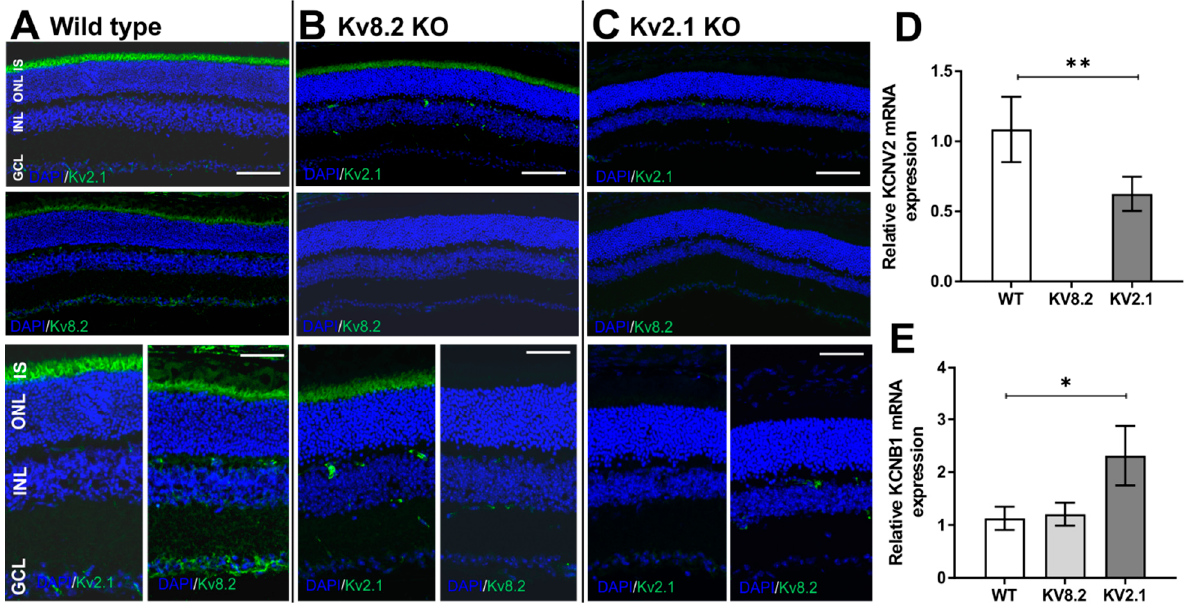
Figure 1. Retinal localization and expression of the voltage-gated K + channel protein subunits Kv8.2 and Kv2.1 in wild type (WT), Kv8.2 knockout (KO) and Kv2.1 KO. ( A – C ) Representative confocal images of the inner segment (IS) area, outer nuclear layer (ONL), inner nuclear layer (INL) and ganglion cell layer (GCL) showing expression of Kv8.2 and Kv2.1 mouse subunits in wild type ( A ), Kv8.2 KO ( B ) and Kv2.1 KO ( C ) retinas at 20× (top panels) and 40× (bottom panels) magnification. Scale bars = 20 µ M (top panels) and 50 µ M (bottom panels). ( D , E ) Relative mRNA expression of Kcnv2 and Kcnb1 genes in all three lines. Results are presented as mean +/ − SD from n = 3 (WT and Kv8.2 KO) and n = 4 (Kv2.1 KO), and p values were obtained through one-way ANOVA and Dunnett’s multiple comparison test post hoc with * p = 0.0094 and ** p = 0.0001.